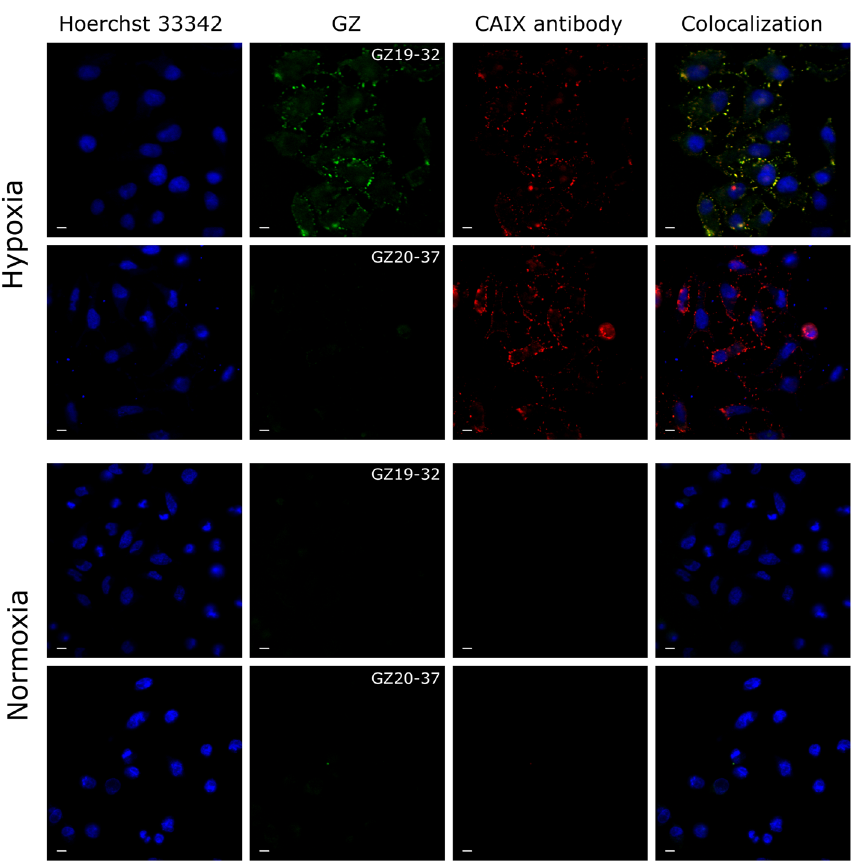
Figure 3. Staining of live HeLa cells (grown under hypoxia or normoxia) incubated with 10 nM GZ19-32 or GZ20-37 showing cell nuclei (Hoechst 33342, blue), binding of the GZ compounds (green), CAIX antibody (red) and their colocalization. The scale bar length is 10